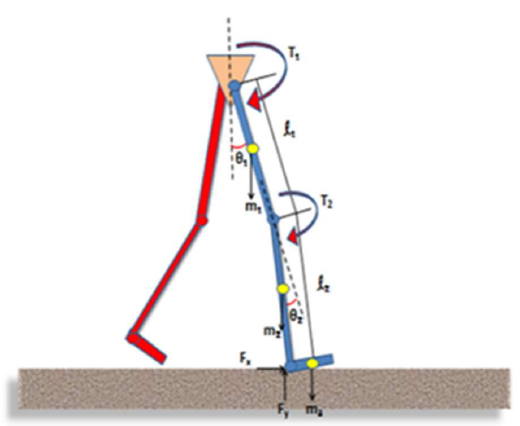
Fig. 2. Single limb stance with hip joint flexion. 3- Stance Phase - Single limb stance: In the case